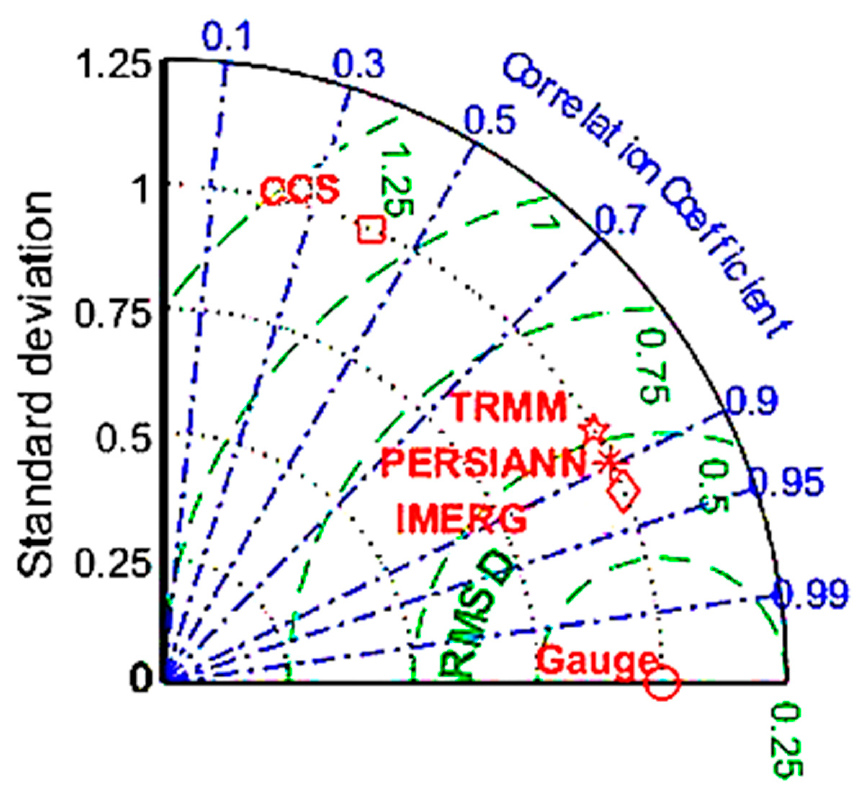
Figure 15. Taylor diagram showing the performance of monthly estimations of SBPD.